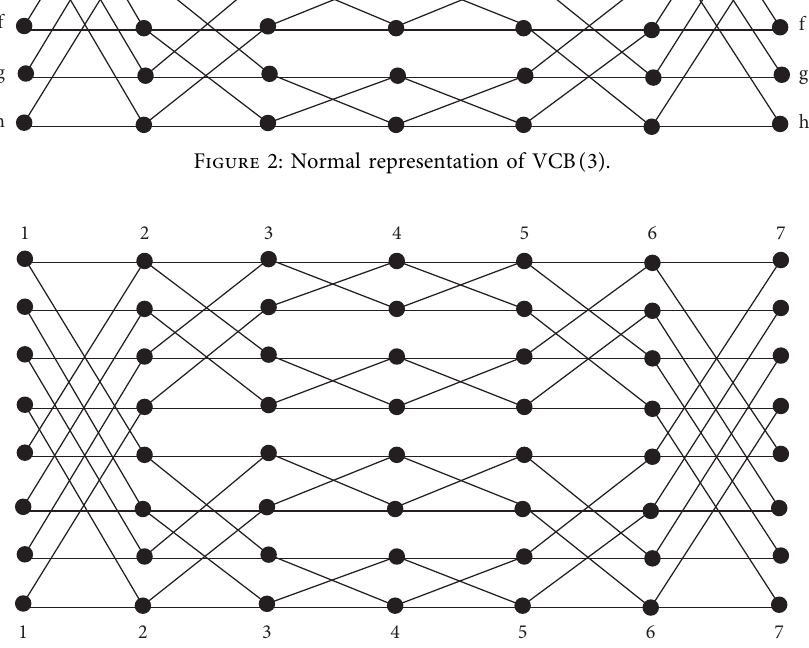
Figure 3: Normal representation of HCB ( 3 ) .